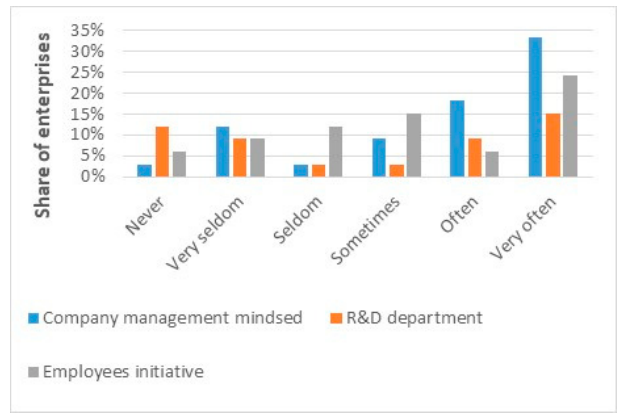
Figure 5. Drivers of innovation (part 3).